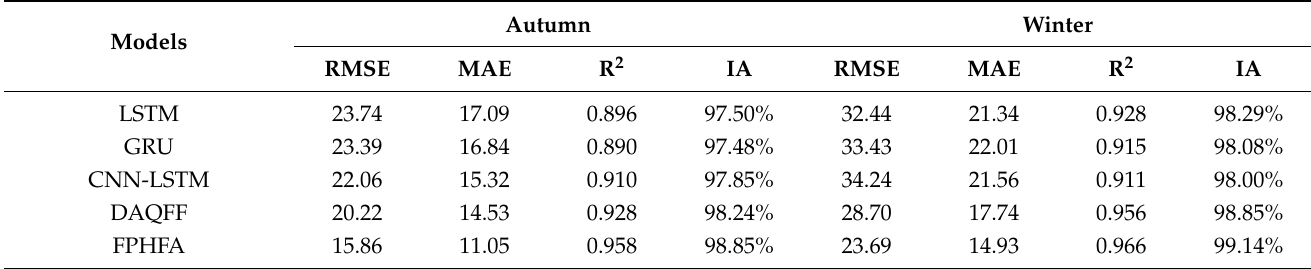
Table 5. The model performance evaluation indicators of models in autumn and winter.